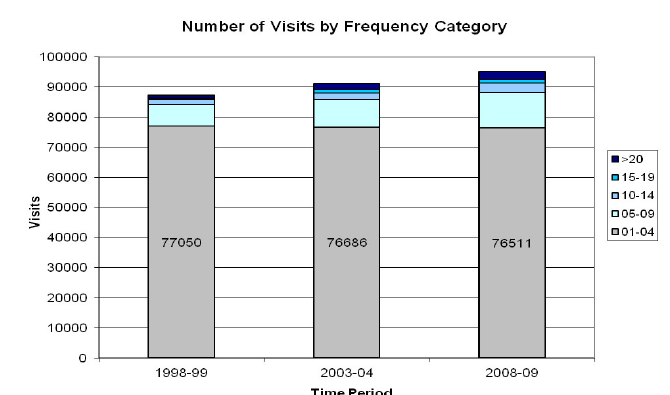
Figure 1. Number of patients in each frequent emergency department users (FEDU) group in years 0, 5, & 10.